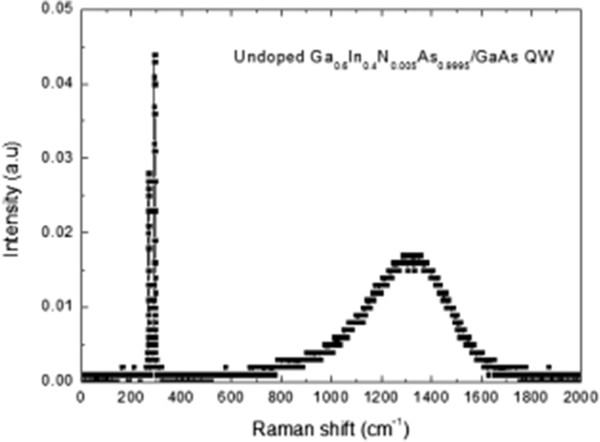
FT-Raman spectrum of undoped Ga0.60In0.40N0.005As0.995/GaAs QW structure.